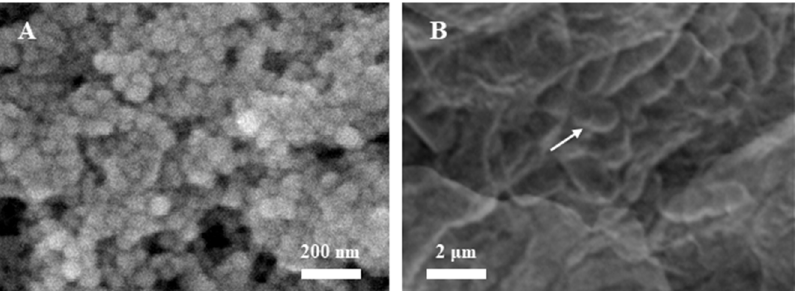
Figure 2. SEM image of ( A ) electro-deposited gold nanoparticles (AuNPs) and ( B ) L. brevis/ ILs/anti- L. brevis /Au/GCE.